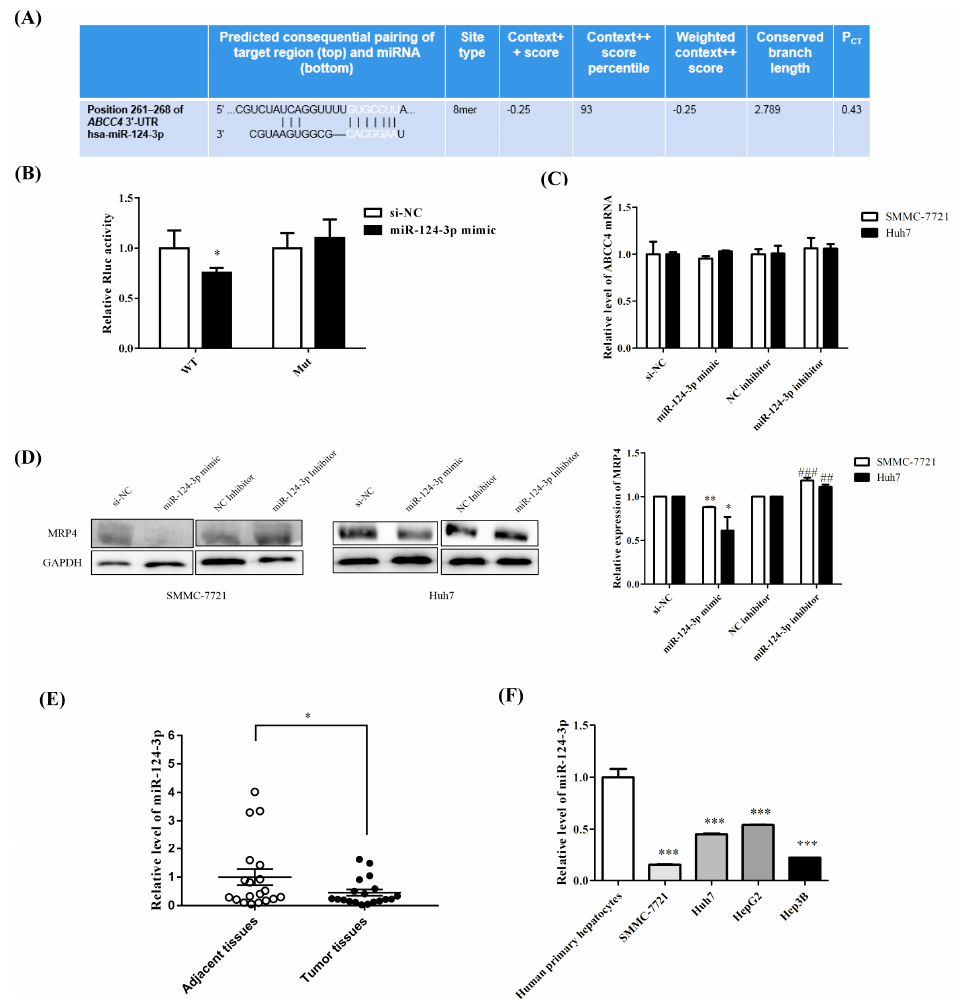
Figure 2. miR-124-3p regulated the expression of MRP4. ( A ) Interaction diagrams between miR-124-3p and ABCC4 3 ′ -UTR by computational prediction. ( B ) Luciferase reporter results showed that miR-124-3p could bind directly with ABCC4 3 ′ -UTR.si-NC stands for negative control. ( C ) mRNA levels of ABCC4 was similar in miR-124-3p mimic transfected cells and control cell lines. ( D ) MRP4 protein expression was reduced in SMMC-7721 and Huh7 cells transfected with 100 nM miR-124-3p mimics for 72 h, while treatment with the miR-124-3p inhibitors had contrasting effects. Results are expressed as mean ± standard error of the mean (SEM) of at least three independent experiments. * p < 0.05, ** p < 0.01, *** p < 0.001, compared with control group. ## p < 0.01, ### p < 0.001, compared with NC inhibitor group. ( E ) RT-qPCR results showed downregulation of miR-124-3p in HCC tissues compared to the adjacent noncancerous tissues. U6 was used to normalize the miRNA expression, n = 19. ( F ) Significant downregulation of miR-124-3p was observed in HCC cell lines compared to that in the human primary hepatocytes. Differences between two experimental groups were analyzed by the Student’s t test. * p <0.05, ** p <0.01, *** p